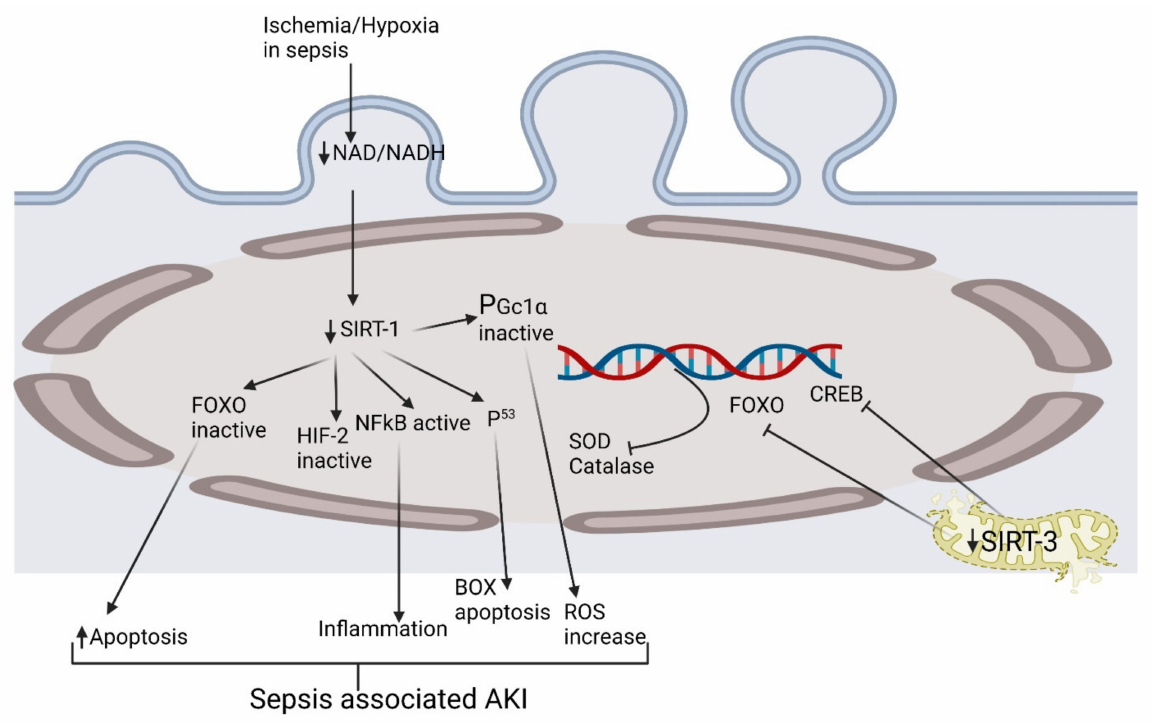
Figure 1. Exploring the pathophysiological activation of various biomolecular pathways in septic acute kidney injury. CREB, cAMP-response element-binding protein; HIF-2, hypoxia-inducible factor- 2; FOXO, forkhead box O; NAD, nicotinamide adenine dinucleotide; NF- κ B, nuclear factor kappa- light-chain-enhancer of activated B cells; PGc1 α , peroxisome proliferator-activated receptor-gamma coactivator (PGC)-1alpha; ROS, reactive oxygen species; SIRT1, Sirtuin 1; SODs, Ssuperoxide dismu-